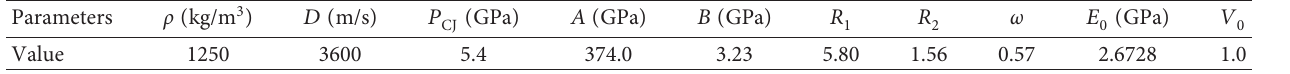
Table 2: Parameters of explosive and JWL equation.